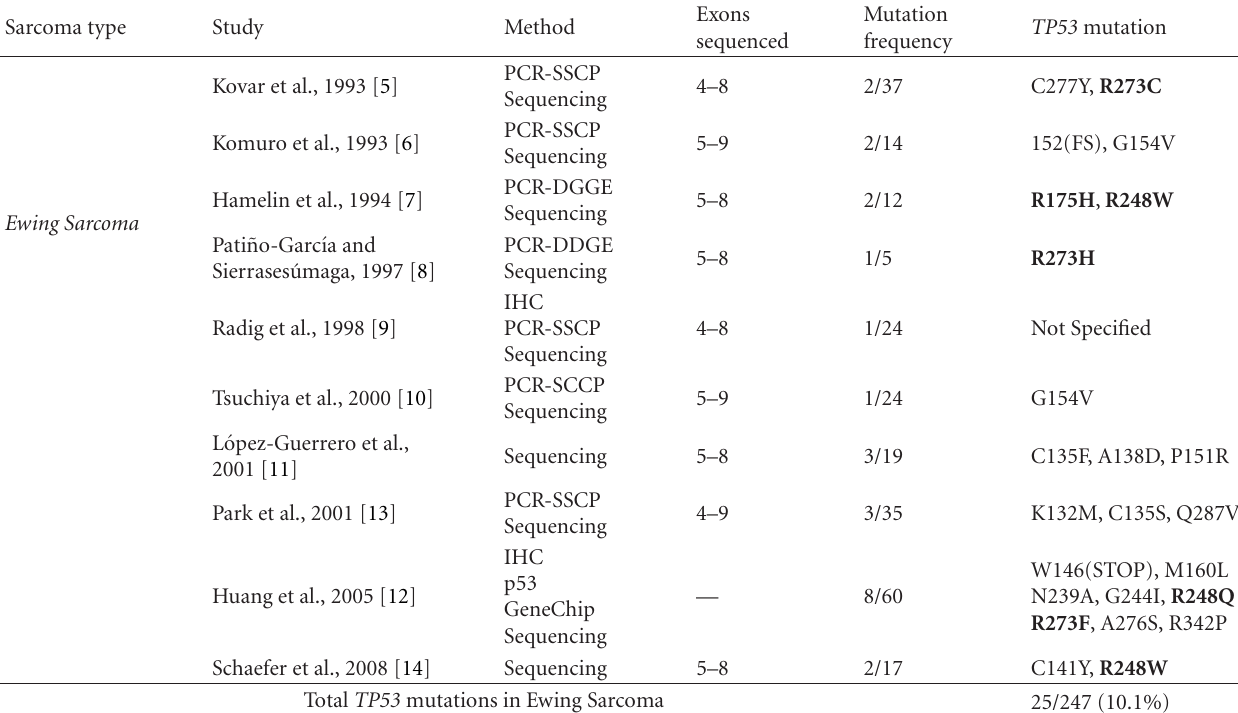
Table 1: TP53 Mutations in Ewings Sarcoma confirmed by DNA